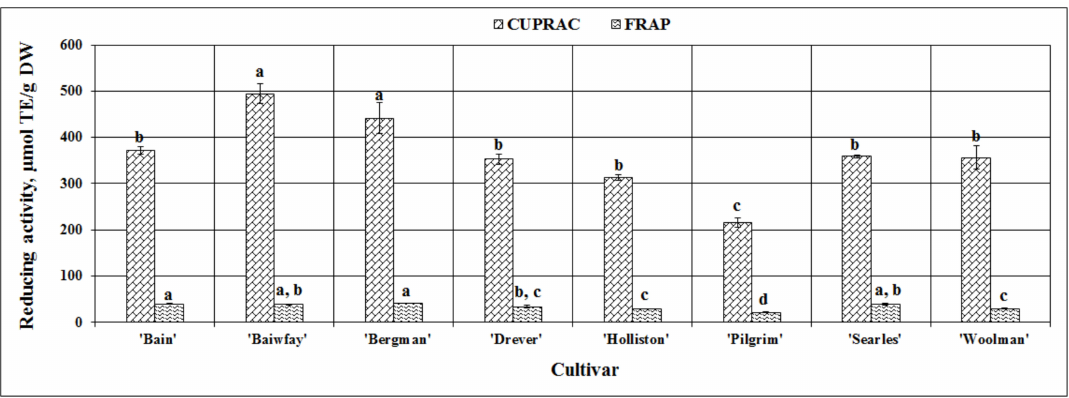
Figure 7. Variability in the reducing activity in vitro in fruit sample extracts of di ff erent American cranberry cultivars; di ff erent letters indicate statistically significant ( p < 0.05) di ff erences between the studied cranberry fruit